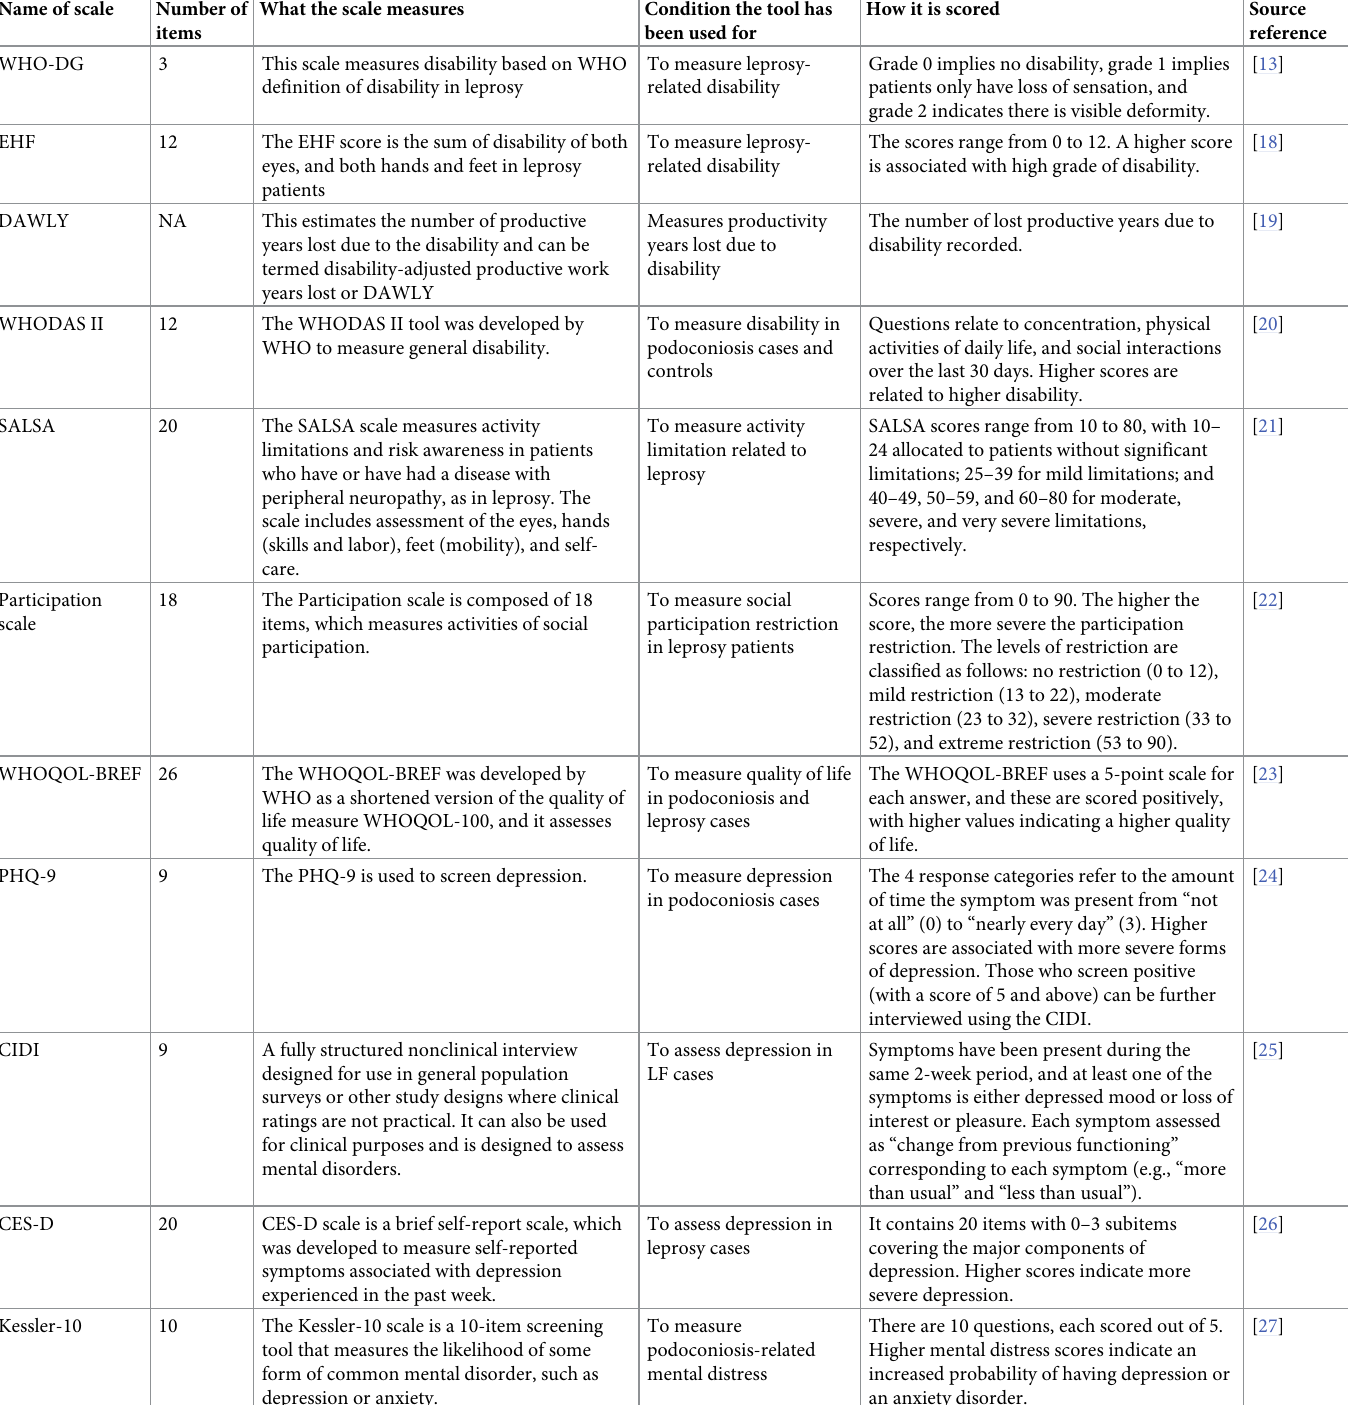
Table 2. Description of outcome